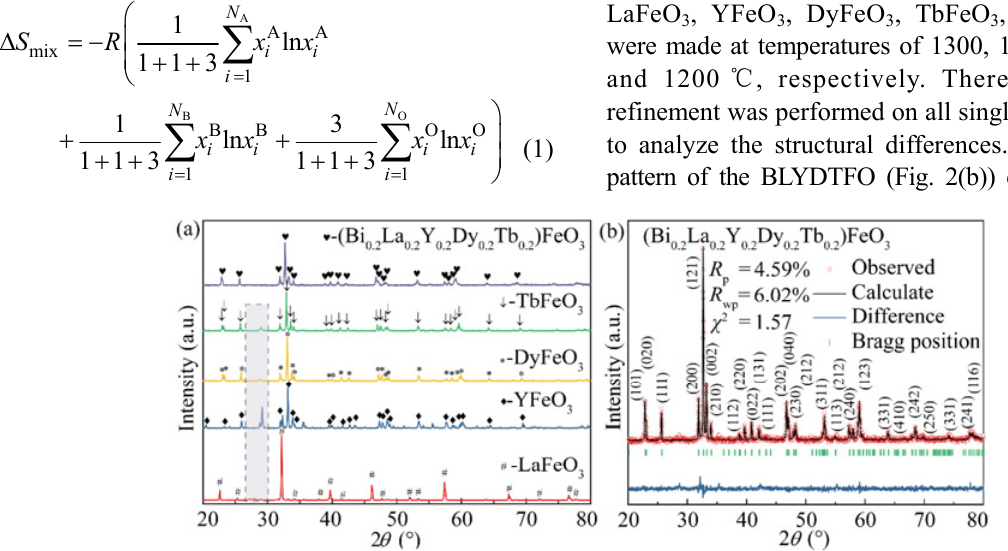
Fig. 2 Phase structures: (a) XRD patterns of different powders calcined at 1100 ℃ and (b) Rietveld refinement of XRD pattern of BLYDTFO ceramics sintered at 1200 ℃ where R p is the pattern variance factor, R wp is the weighted pattern variance factor, and 2  is the goodness of